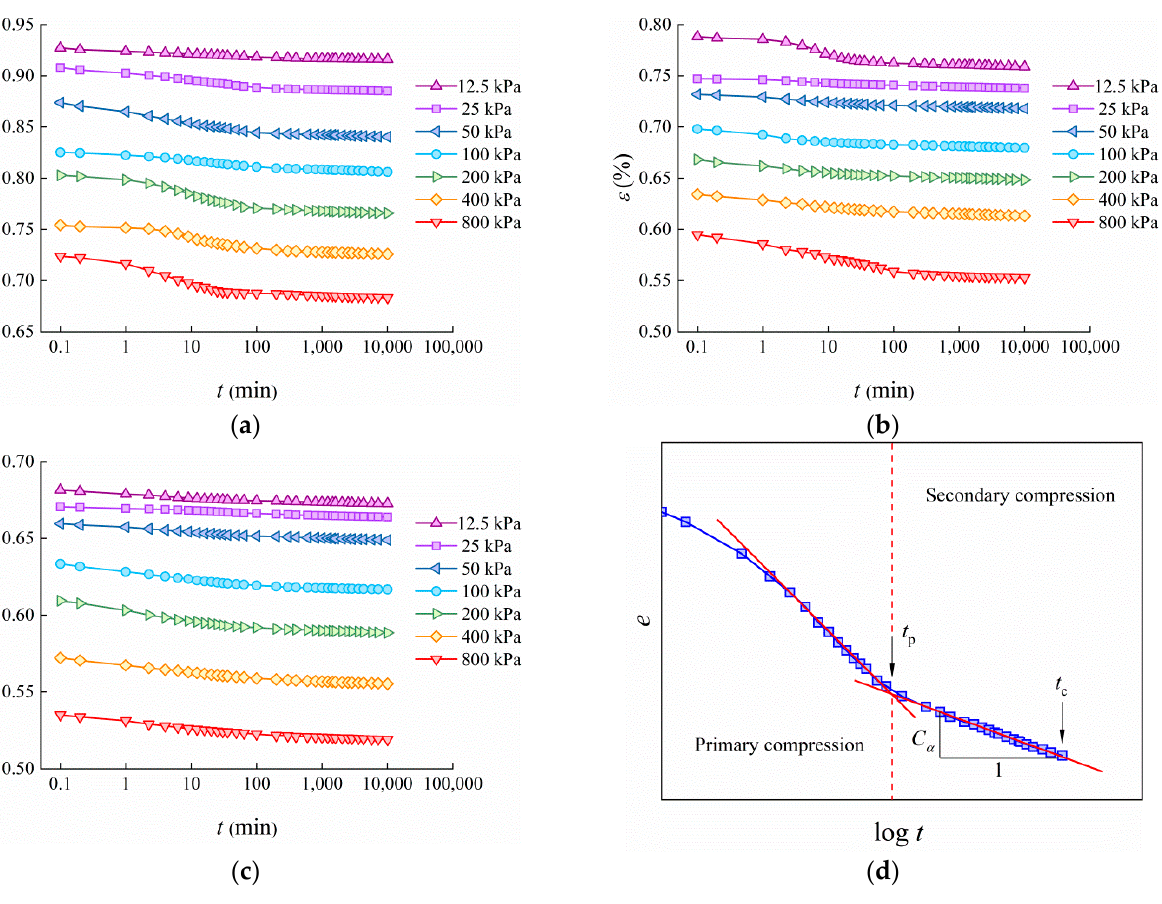
Figure 4. e –log t curves: ( a ) TJ, ω a = 20%; ( b ) QD, ω a = 20%; ( c ) WH, ω a = 20%; ( d ) diagram of primary and secondary compression partition.